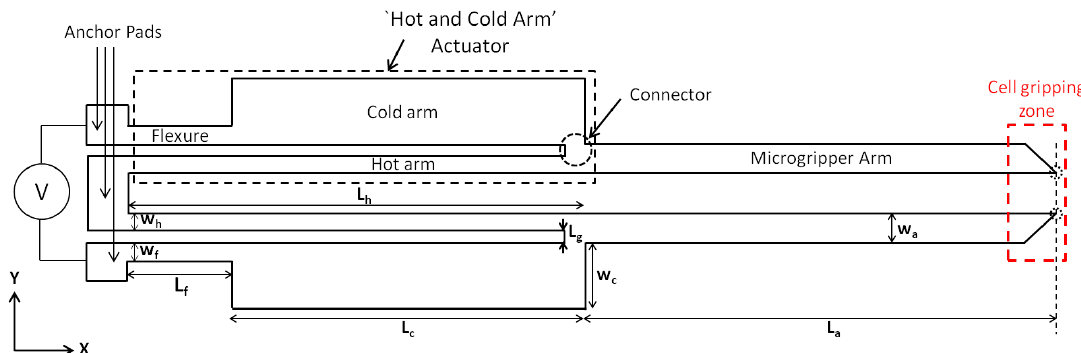
Figure 1. Schematic illustration of the electrothermal microgripper design based on the U-shape ‘hot and cold arm’ actuator configuration. The encircled points within the cell gripping zone indicate the arm tip points that will be later investigated for their x -, y - and z -displacements. The cell gripping zone is to undergo further development in future